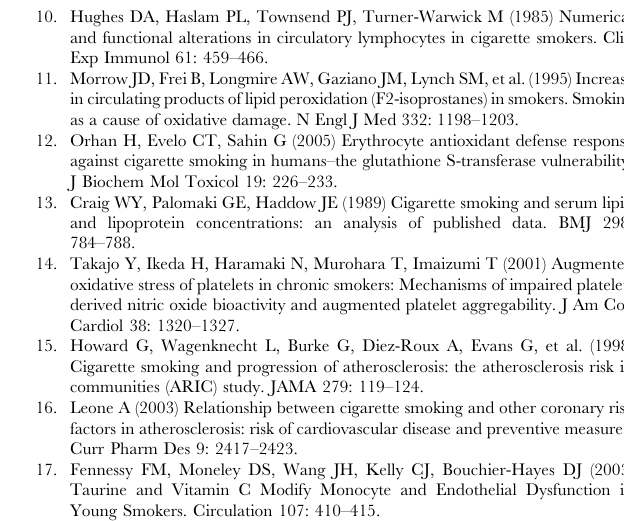
Figure S2 Expression of genes encoding inflammatory mediators and adhesion molecules. Figure S3 Expression of genes encoding redox enzymes. (EPS) Text S1 Additional information regarding the methods